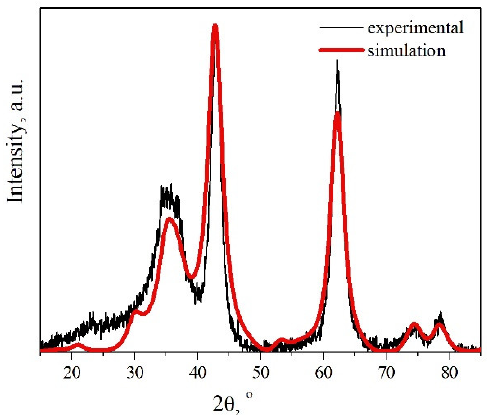
Figure 7. Simulation of XRD patterns for MgGa oxide (mole fraction of Mg 2+ = 0.67, T = 550 °C).